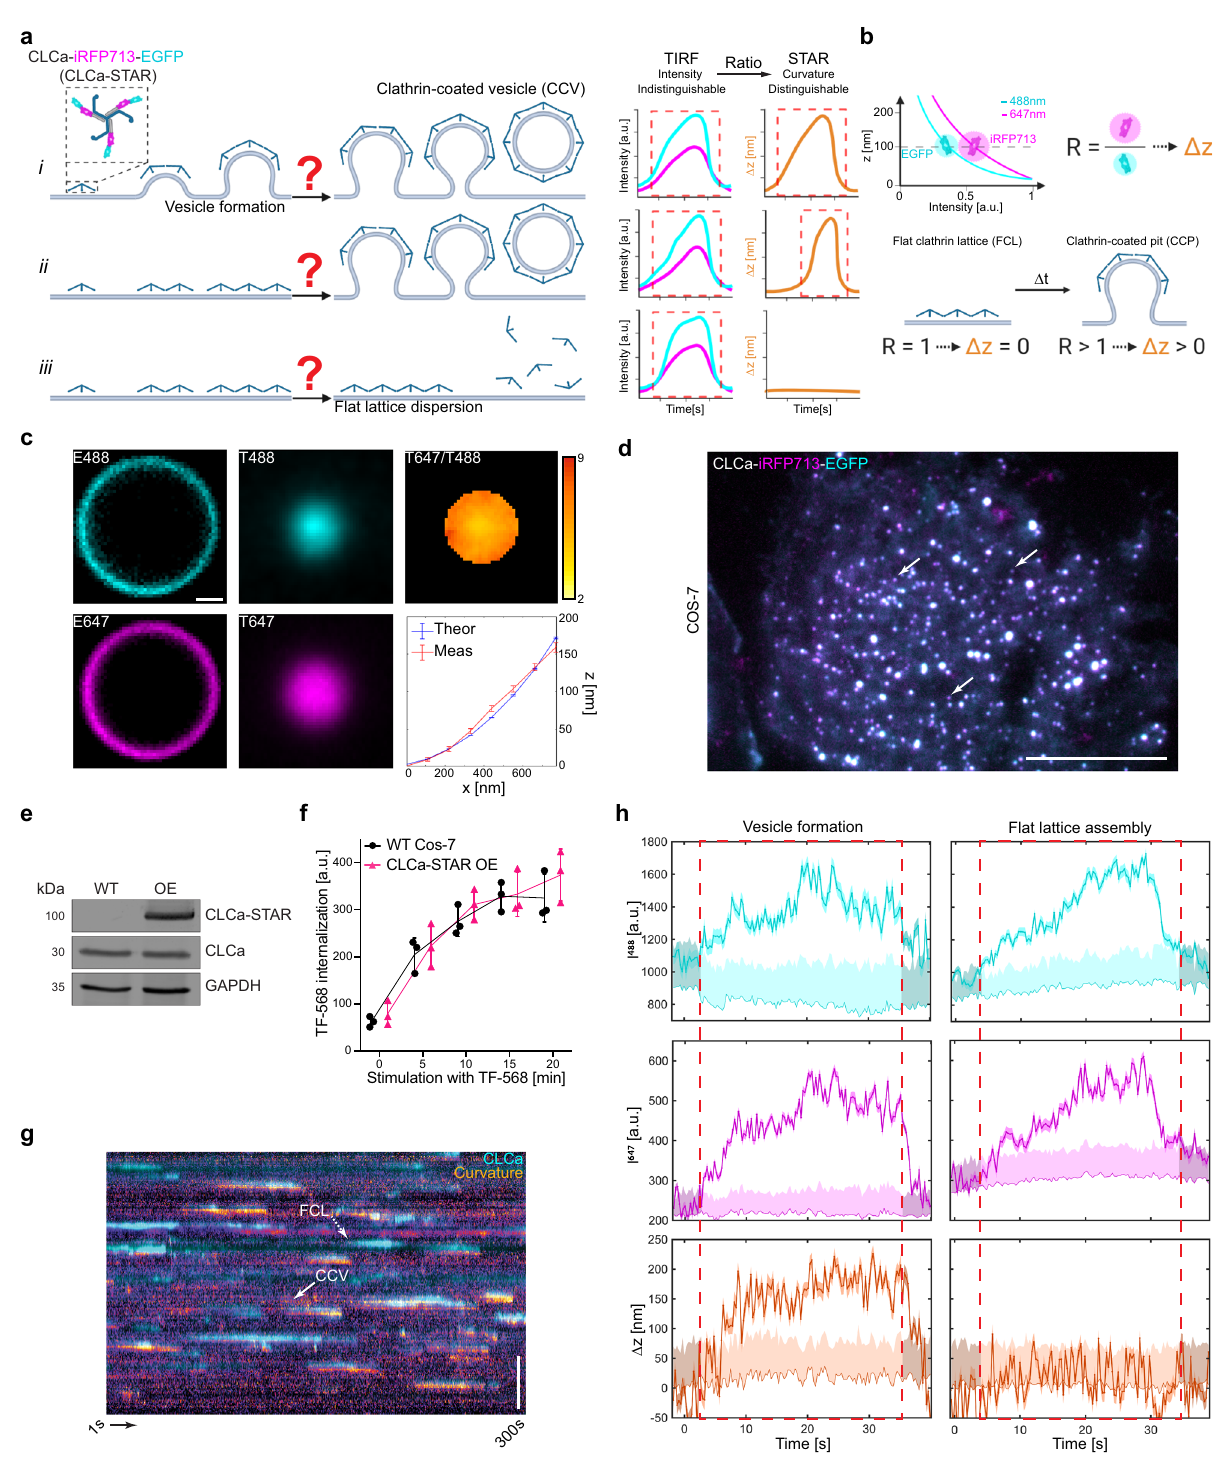
images showed that the labeling was uniform, and the micro- spheres were monodispersed. TIRF illuminates only the “ bottom ” of the microsphere in contact with the coverslip, and the larger penetration depth of the 647 nm excitation is re fl ected by the larger fl uorescent zone under the bead. The height pro fi le ( Δ z), calculated from the fl uorescence intensity ratio of 31 micro- spheres, was in agreement with the theoretical pro fi le calculated based on the microsphere geometry 20 . This con fi rms STAR accurately reports changes in axial position ( Δ